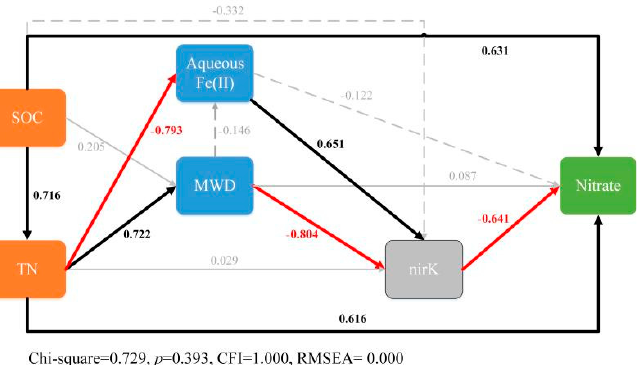
Figure 5. Structural equation model (SEM) describing the direct and indirect contributions of NO 3 − - N.